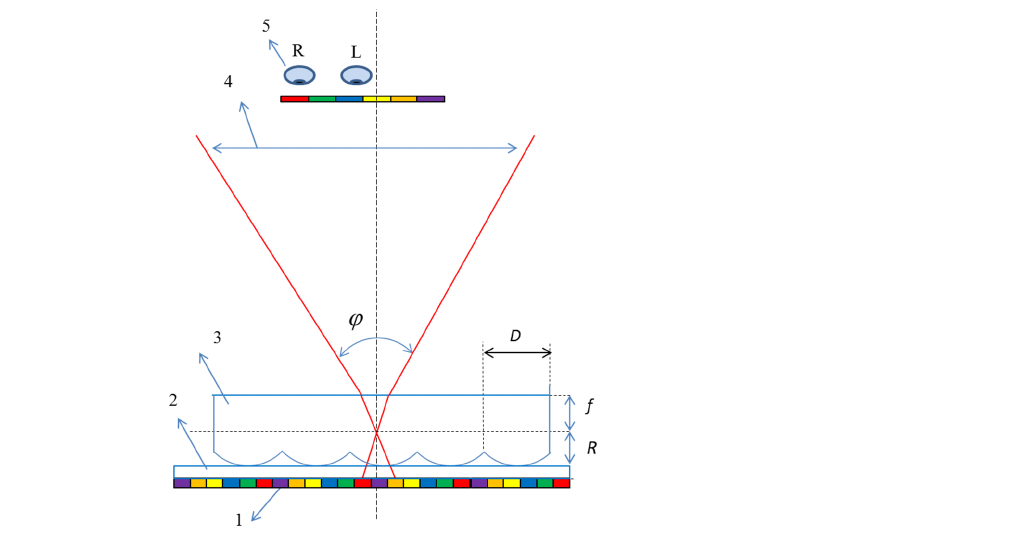
Figure 10. Schematic view of the mobile 3D display. 1—Display element; 2—glass plate; 3—lentic- ular lens; 4—viewing zone; 5—observer; ϕ —viewing angle; D —lens-pitch; f —focal length; and R —curvature radius of the elemental lens.